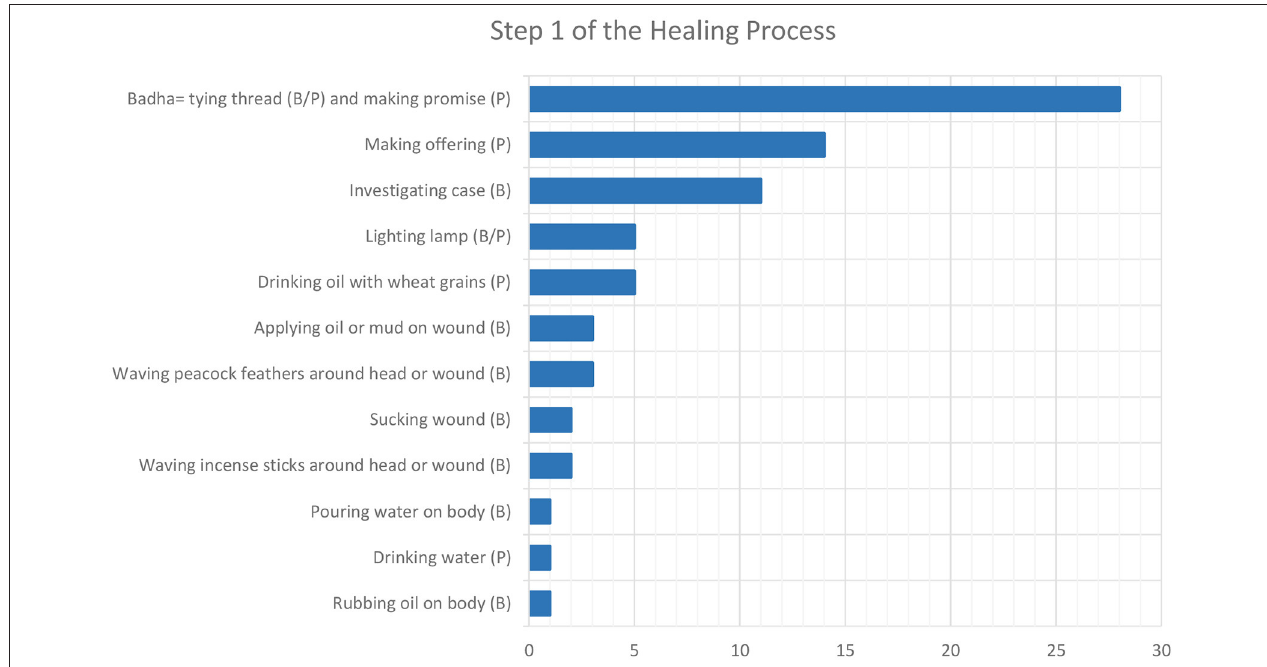
FIGURE 2 | Number of interviewees who mentioned the actions to take (by the bhuva, B, or the patient, P) during the first step of the healing